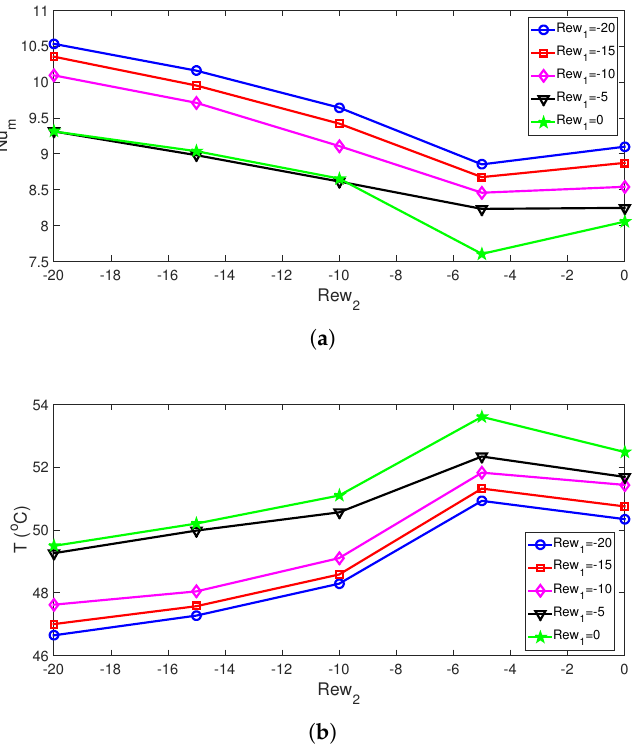
Figure 5. Average Nu ( a ) and average PST ( b ) for different rotational speeds of the cylinders (Rc = 0.1H, Sc = 6Rc, ∆ T = 10, SVF = 3%). Impacts of size and distance between the cylinders on the streamline variations are shown in Figure 6. The rotational effects on the flow pattern become significant when the cylinder size is increased. The vortex size and distribution are significantly